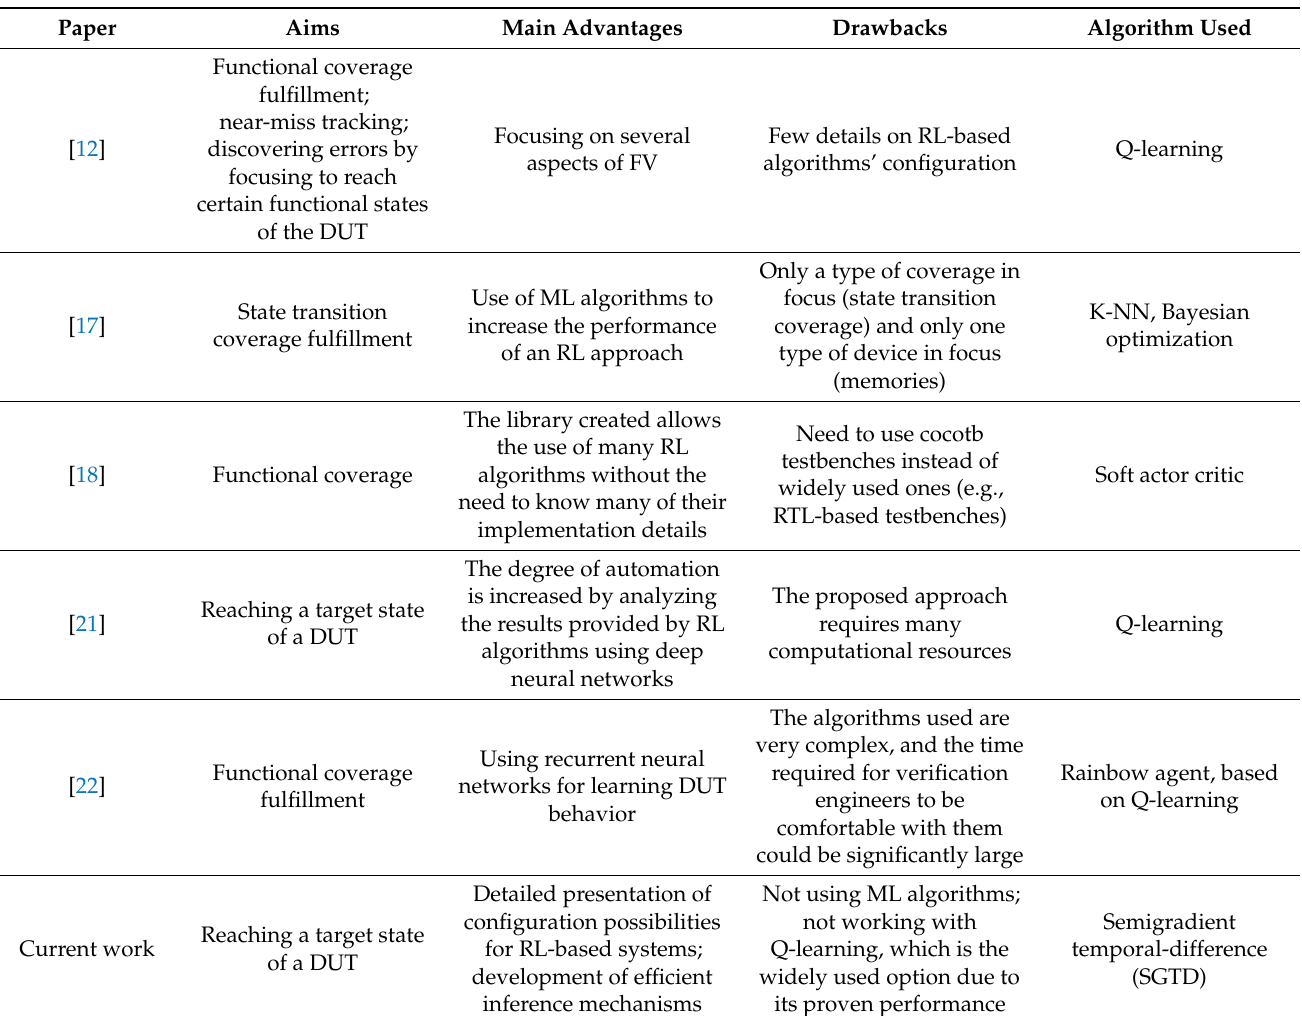
Table 1. Differences between related